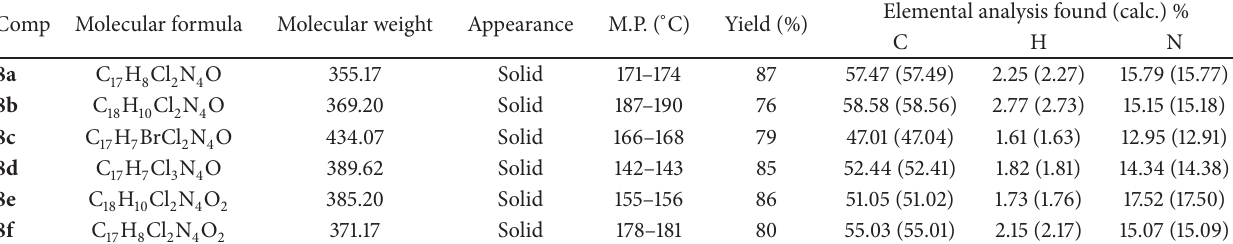
Table 1: Physical data of the compounds 8(a–f)